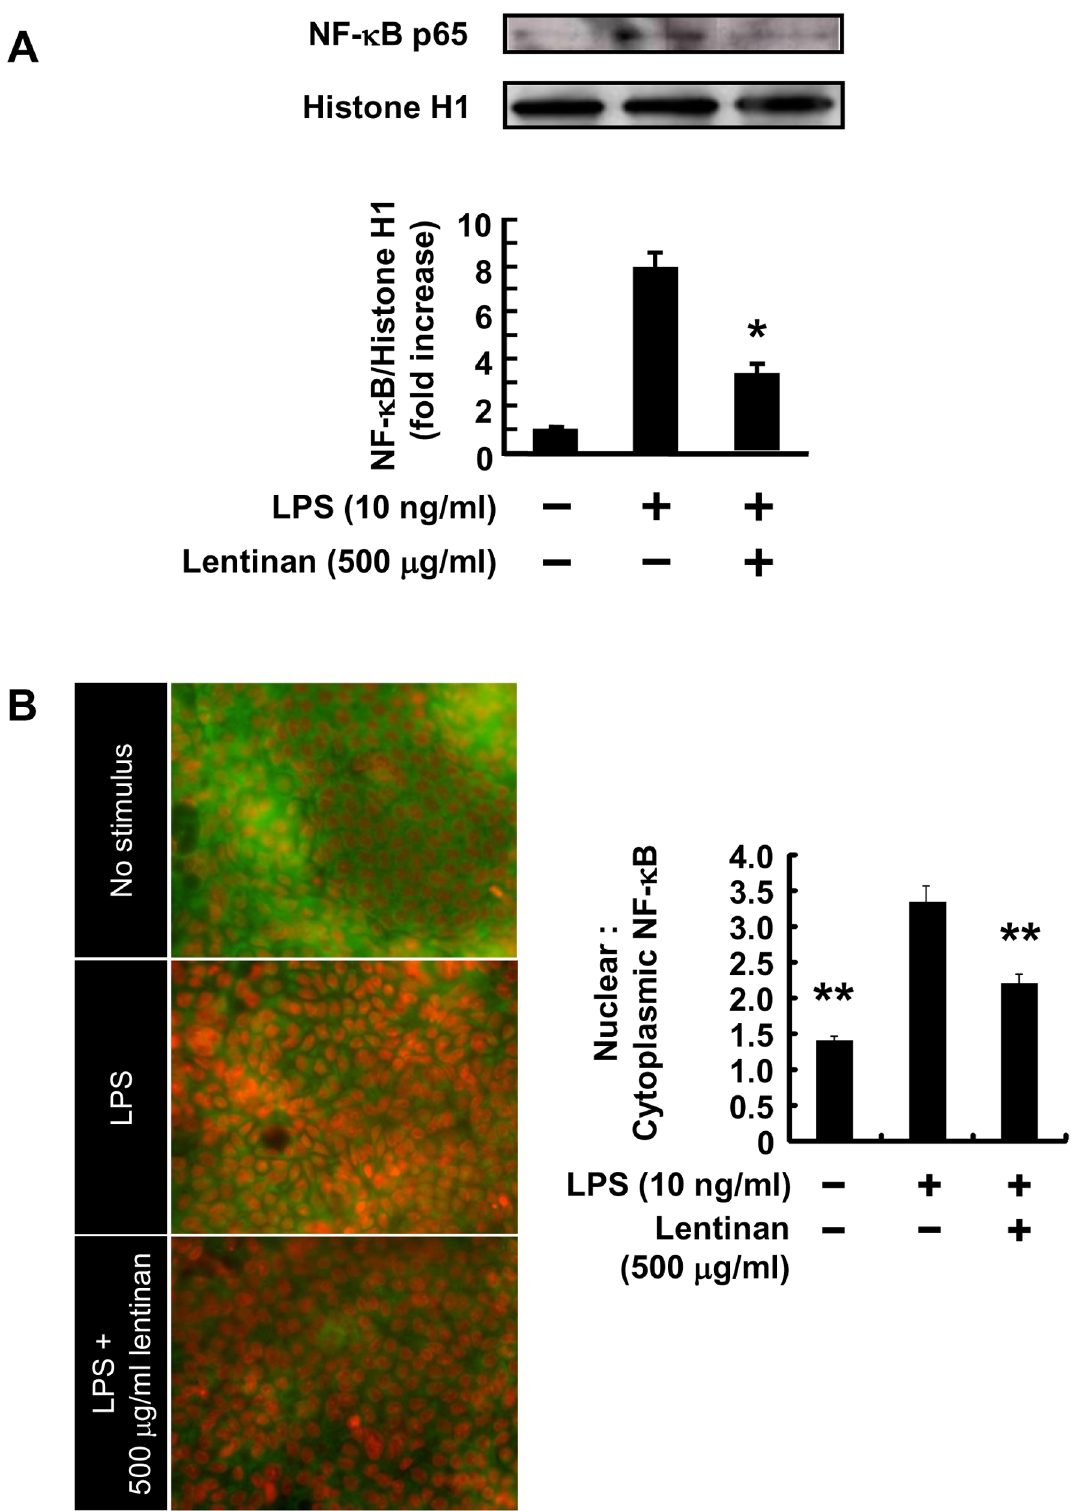
Figure 3. Lentinan inhibits NF- k B p65 nuclear translocation in Caco-2 cells. Lentinan (500 m g/ml) was added into the apical compartment of Caco-2/RAW264.7 co-culture model for 3 h. Subsequently, LPS was added to the basolateral compartment at a concentration of 10 ng/ml, followed by incubation for an additional 2 h. (A) Western blot analysis of the NF- k B p65 subunit was performed on nuclear extracts from Caco-2 cells. (B) Image analysis was performed according to the method described previously [26]. The values represent the means 6 SE. Experiments were repeated for two times in triplicate. * P , 0.05, ** P , 0.01 vs. LPS control.